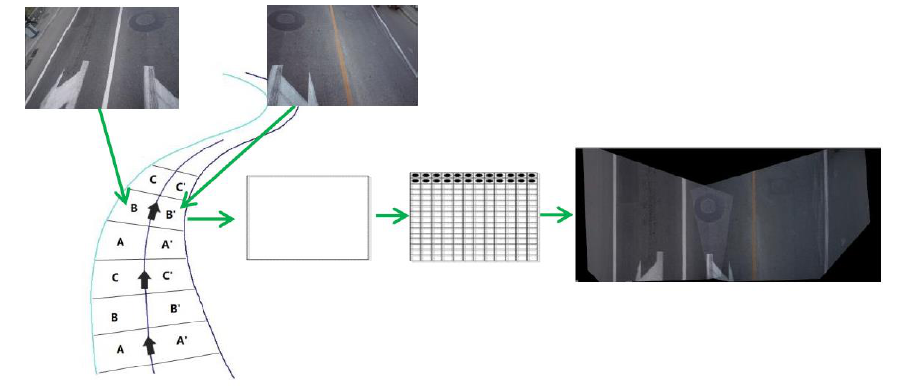
Figure 6. Schematic for the generation of the ground orthophotos.